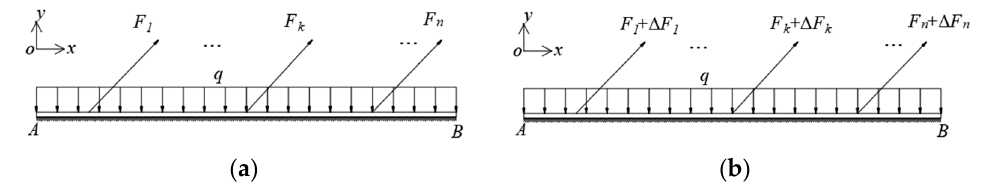
Figure 1. Stress analysis diagram of the girder section: ( a ) Stress state of beam AB in the healthy state; ( b ) Stress state of beam AB after cable damage.